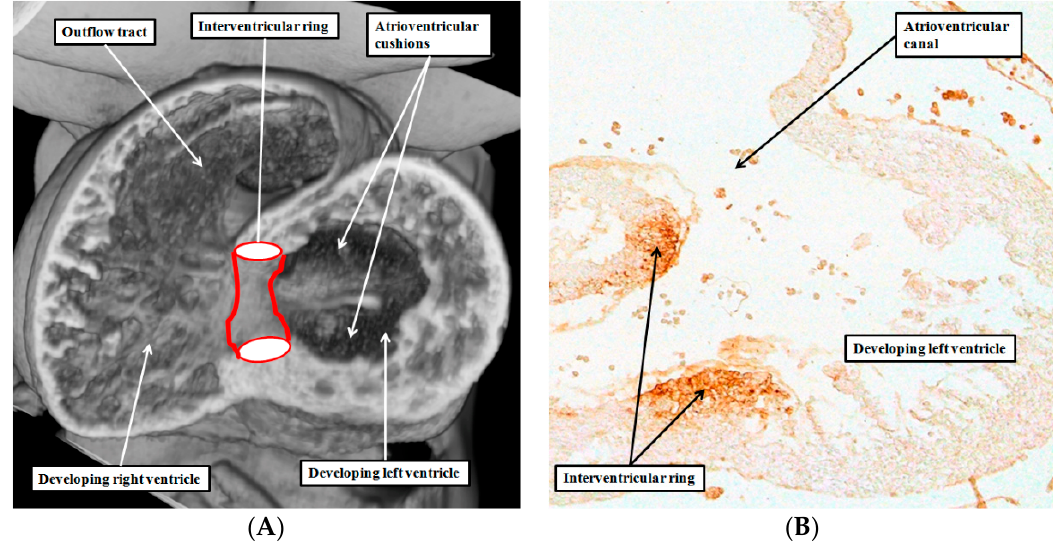
Figure 1. The left hand panel ( A ) is taken from an episcopic dataset prepared from a mouse embryo at E10.5. It is cut along the long axis of the ventricular loop, and shows the location of the interventricular ring, which has the inner heart curvature as its cranial margin, and the developing muscular ventricular septum as the caudal margin. The right hand panel ( B ) is a comparable section from a human embryo processed with an antibody to the nodose ganglion of the chick heart. It shows that the cranial margin of the interventricular ring not only occupies the inner heart curvature, but also forms the rightward margin of the atrioventricular canal. The original section was prepared in Amsterdam by Professor Andy Wessels, and is reproduced with his permission.